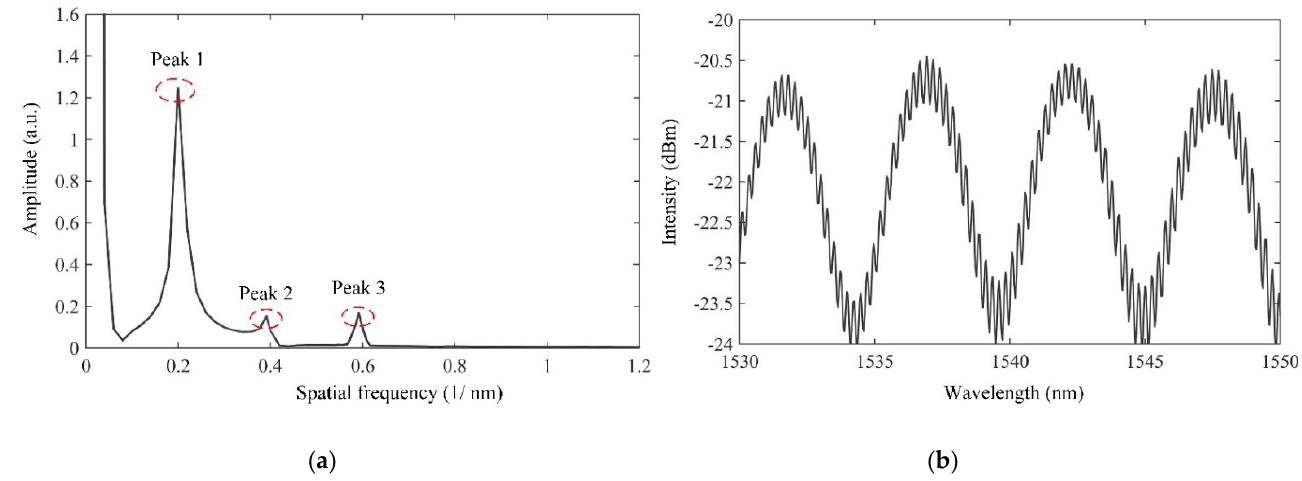
Figure 3. ( a ) Reflection spectrum of the fabricated CFPI sensor; ( b ) spatial frequency spectrum.